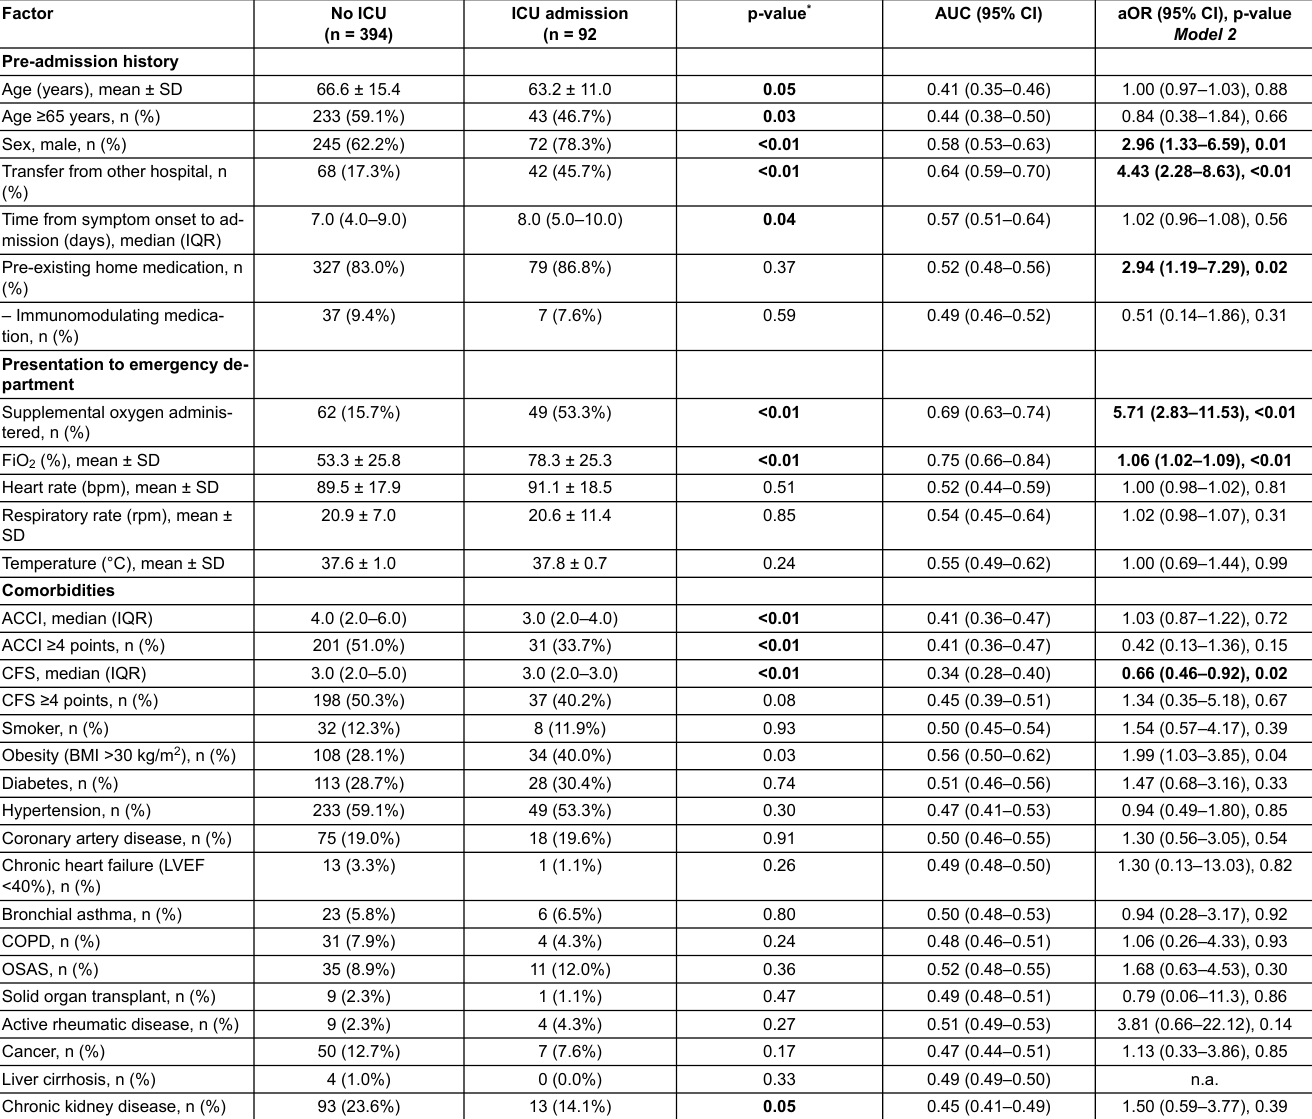
Table 4: Association and discrimination of baseline characteristics and vital signs upon admission stratified by ICU admission.